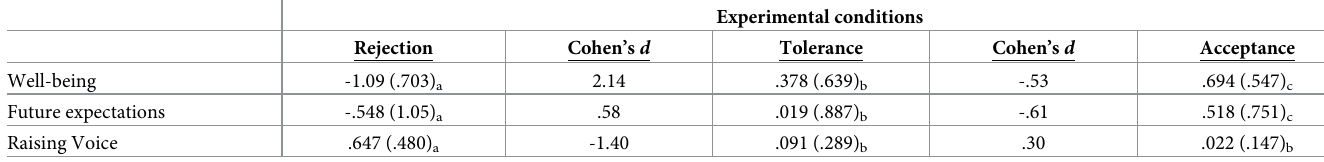
Table 4. Key outcome variable contrasts for Study